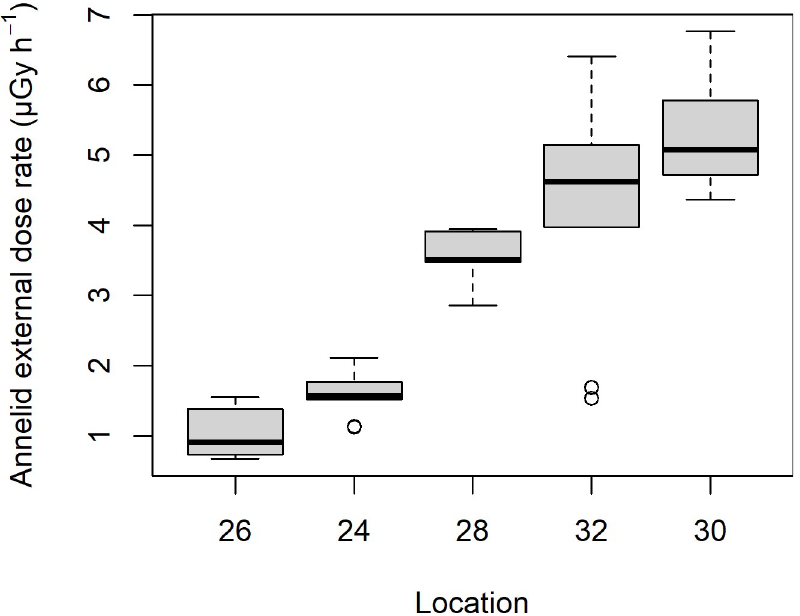
Fig 11. Boxplot of external dose rate estimated with the ERICA tool for an